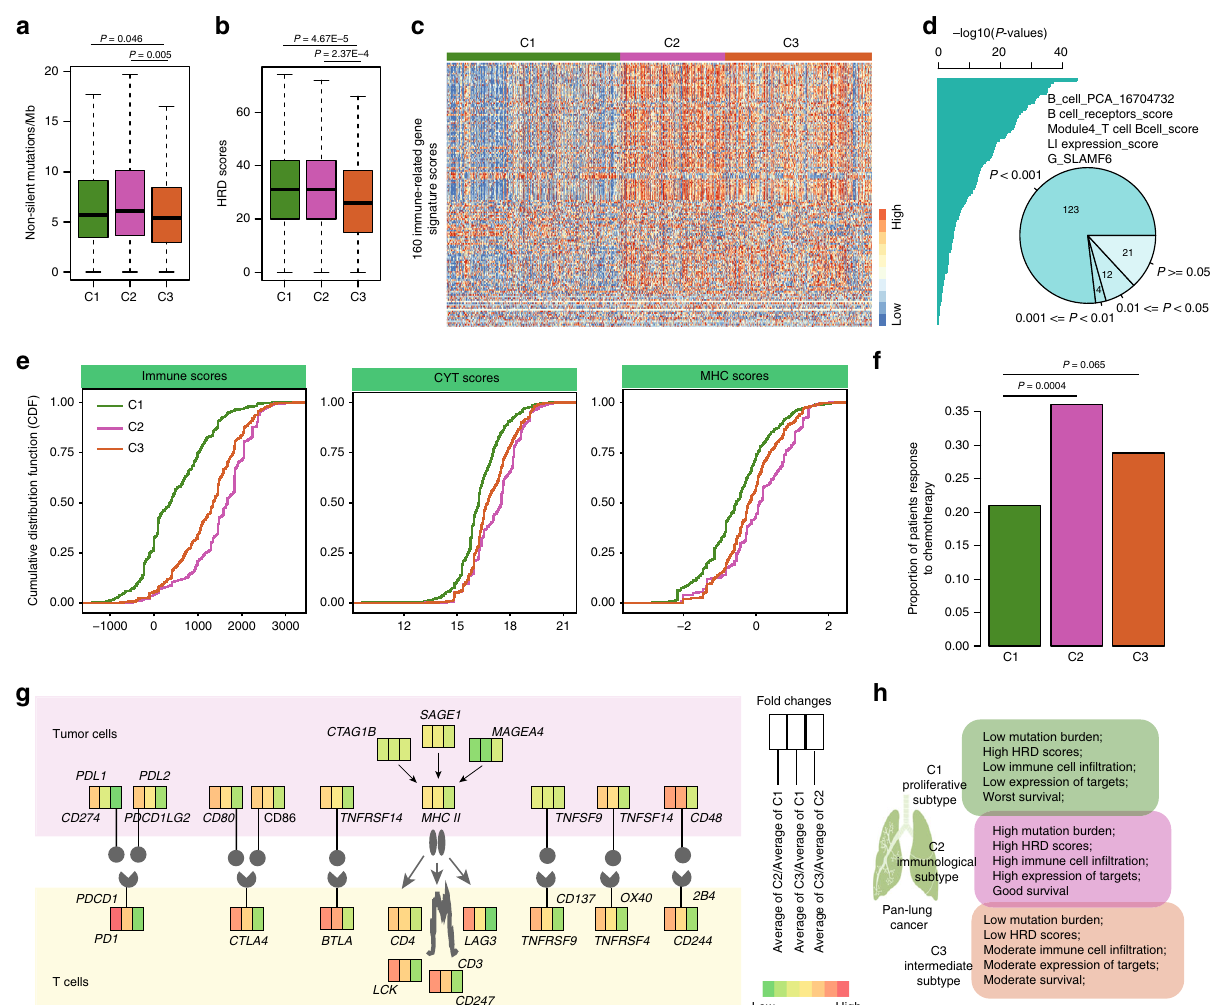
Fig. 6 The immunological characterization of different lung cancer subtypes. a The mutation burden for patients in different subtypes. n1 = 392, n2 = 253, and n3 = 343 biologically independent samples examined. P -values for one-sided Wilcoxon ’ s rank-sum tests. b The HRD score distribution for patients in different subtypes. n1 = 405, n2 = 253, and n3 = 352 biologically independent samples examined. P -values for one-sided Wilcoxon ’ s rank-sum tests. c Heat map showing 160 immune-related gene signature scores for patients across different subtypes. d The distribution of P -values obtained by ANOVA analysis. The pie plot shows the proportion of signatures with different P -values. e The cumulative distribution of immune, CYT, and MHC scores for patients of different cancer subtypes. f The proportion of patients that respond to chemotherapy in different subtypes. Two-sided Fisher ’ s exact test. g Diagram of the immune checkpoint pathway, comparing tumors in different subtypes. h Summary of features for patients of different subtypes. The center of the boxplots are median values, the bounds of the boxes are 25% and 75% quantiles. The minima are 25% quantile − 1.5*interquartile range (IQR) and the maxima are 75% quantile + 1.5*IQR. Source data are provided as a Source Data fi